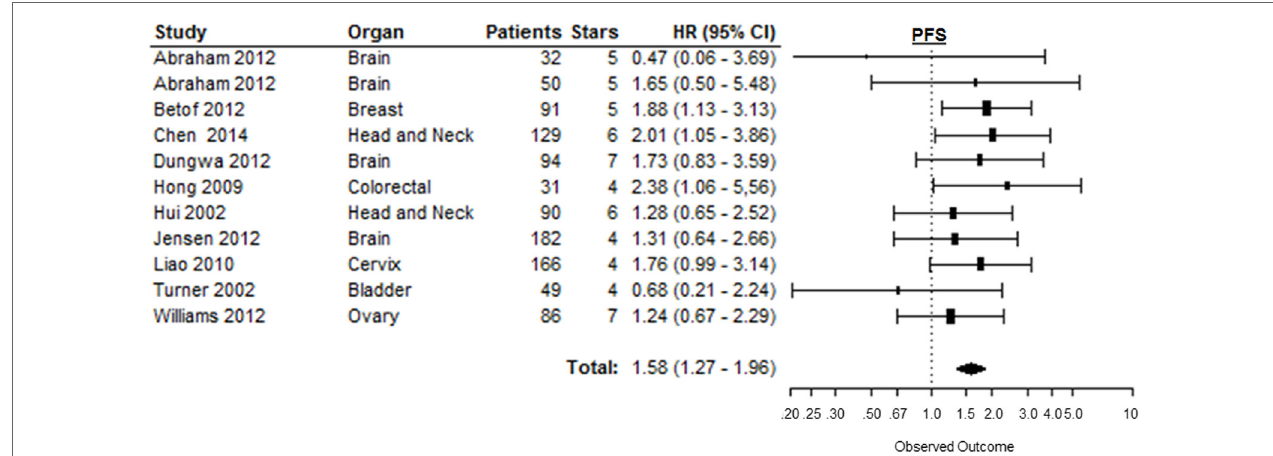
FiGURe 8 | Forest plot of the papers describing the association between CAiX expression and PFS . Horizontal bars represent the HR with corresponding 95%CI. Symbol size represents the assigned weight of the study. The overall HR with 95%CI is visualized with the diamond shape. Dashed line indicates no association between CAIX and prognosis (30, 44, 47, 52, 62, 75, 80, 100, 123,